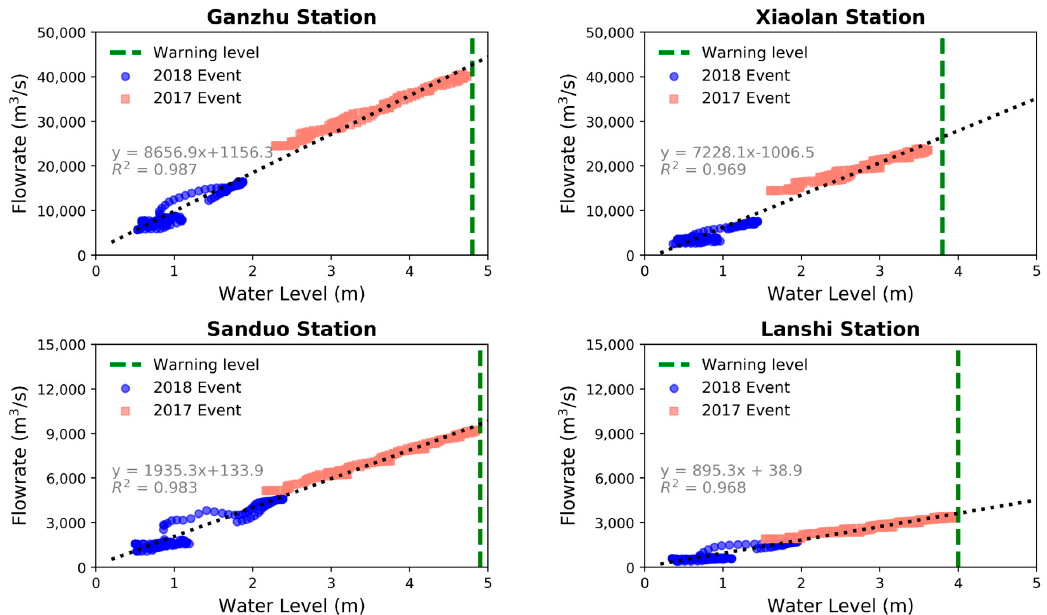
Figure 6. Rating curves for Ganzhu, Xiaolan, Sanduo and Lanshi stations along with R 2 values. The flowrate is simulated using the HEC-HMS model and water level is that observed from the two historical events.